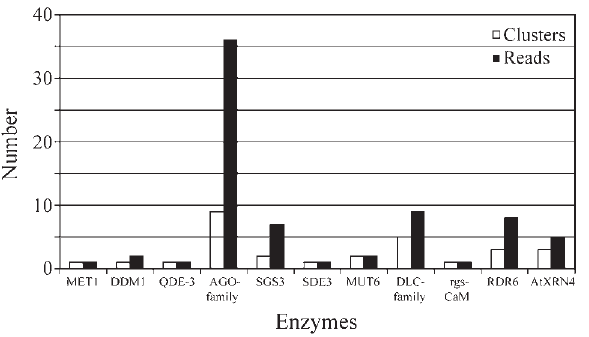
Figure 2 - Cluster distribution and total number of ESTs (in each cluster) encoding enzymes involved in the PTGS